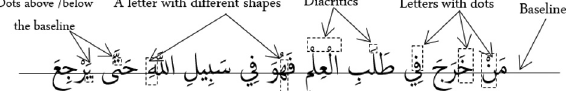
Figure 1. Printed Arabic script